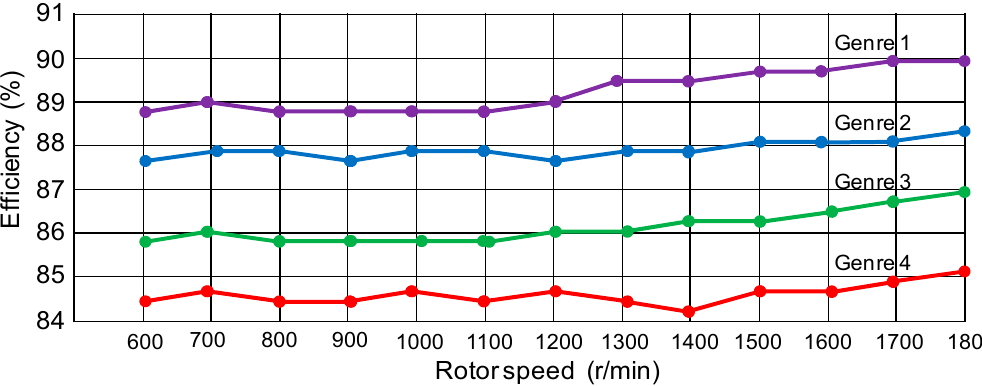
Figure 5. Line chart of comparisons of efficiency for 4 kinds of six-phase synchronous reluctance motors mounted to centrifugal compressor with various speeds.